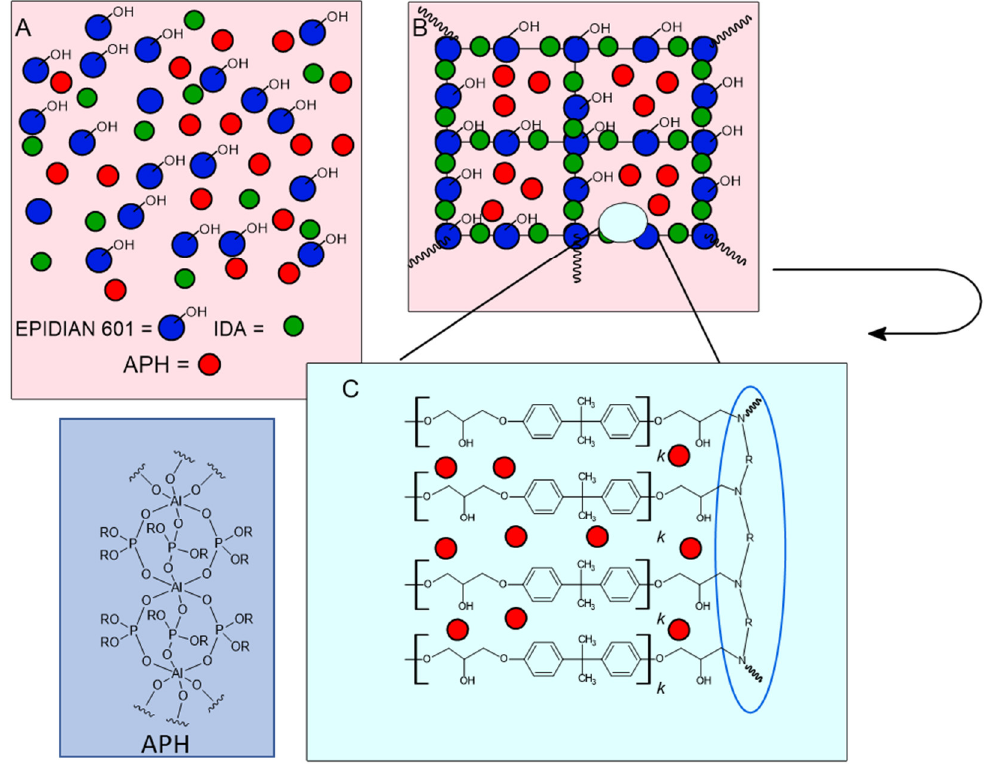
Figure 2. Proposed scheme of polymeric composites structure: ( A ) before and ( B ) after polymerization reaction, ( C ) presents the structure of bond between EP601 and IDA.